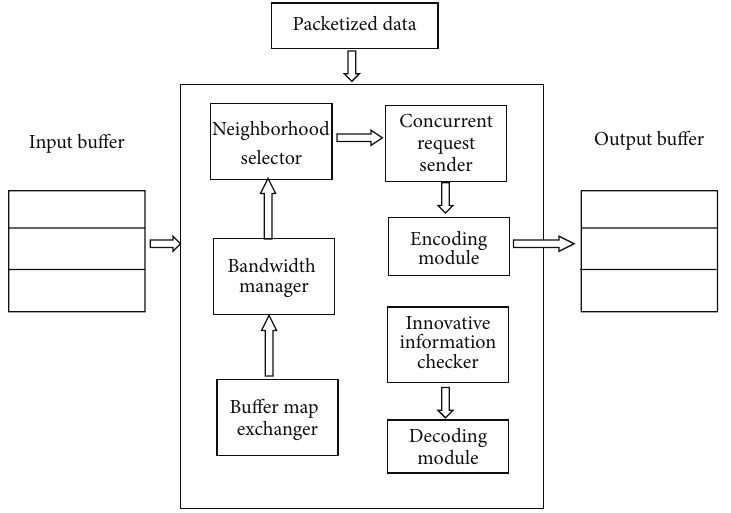
Figure 4: Proposed system